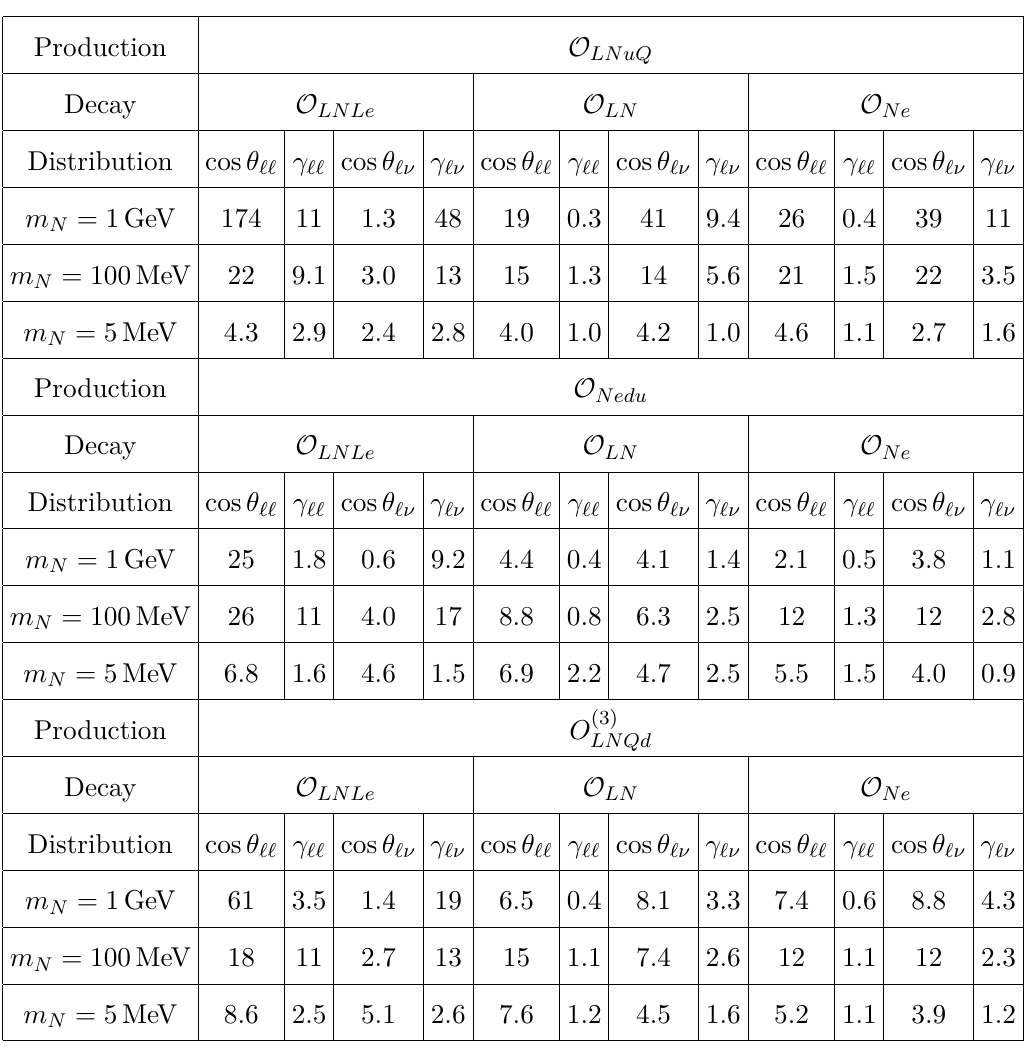
Table 7 . Same as table 6, except for three-body B